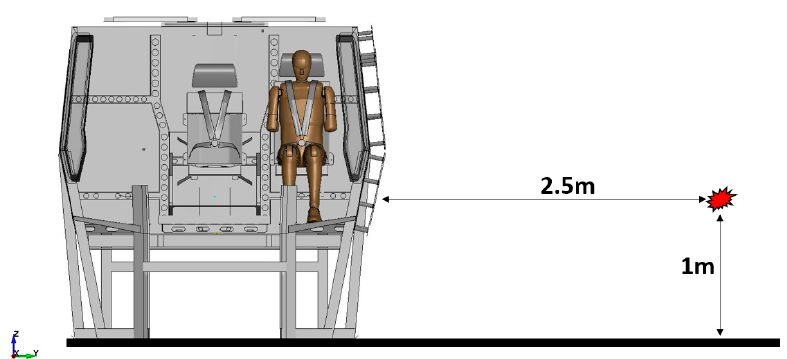
Figure 13. Way of placing the explosive towards the vehicle for side explosion.